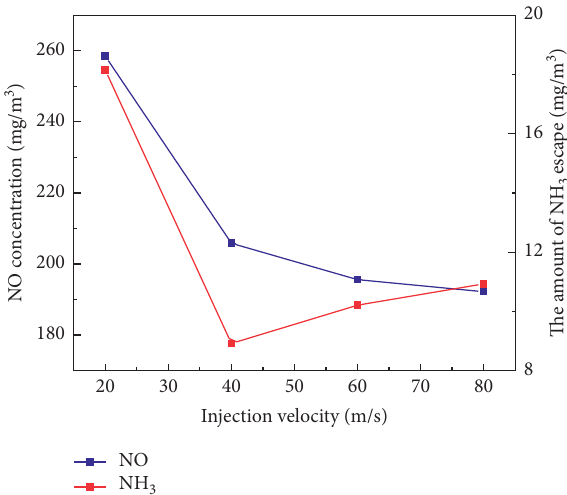
Figure 12: The variations of NO and NH outlet of the decomposing furnace with spray